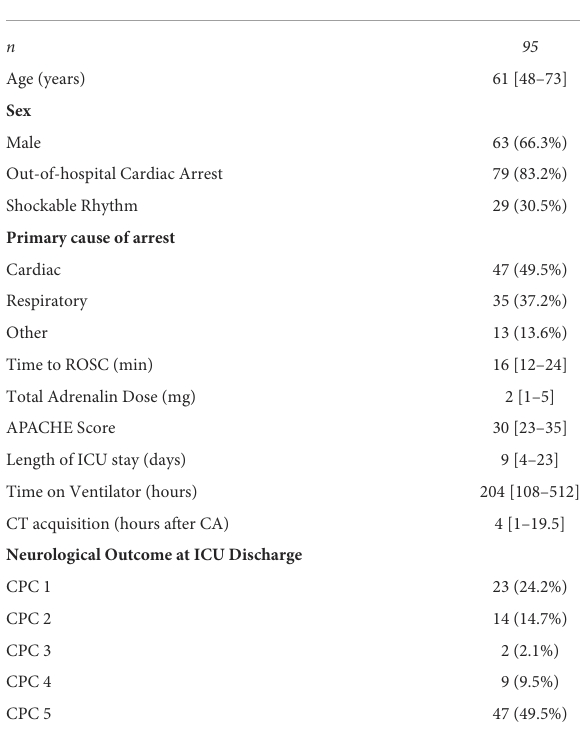
TABLE 1 Baseline data of 95 CA patients.